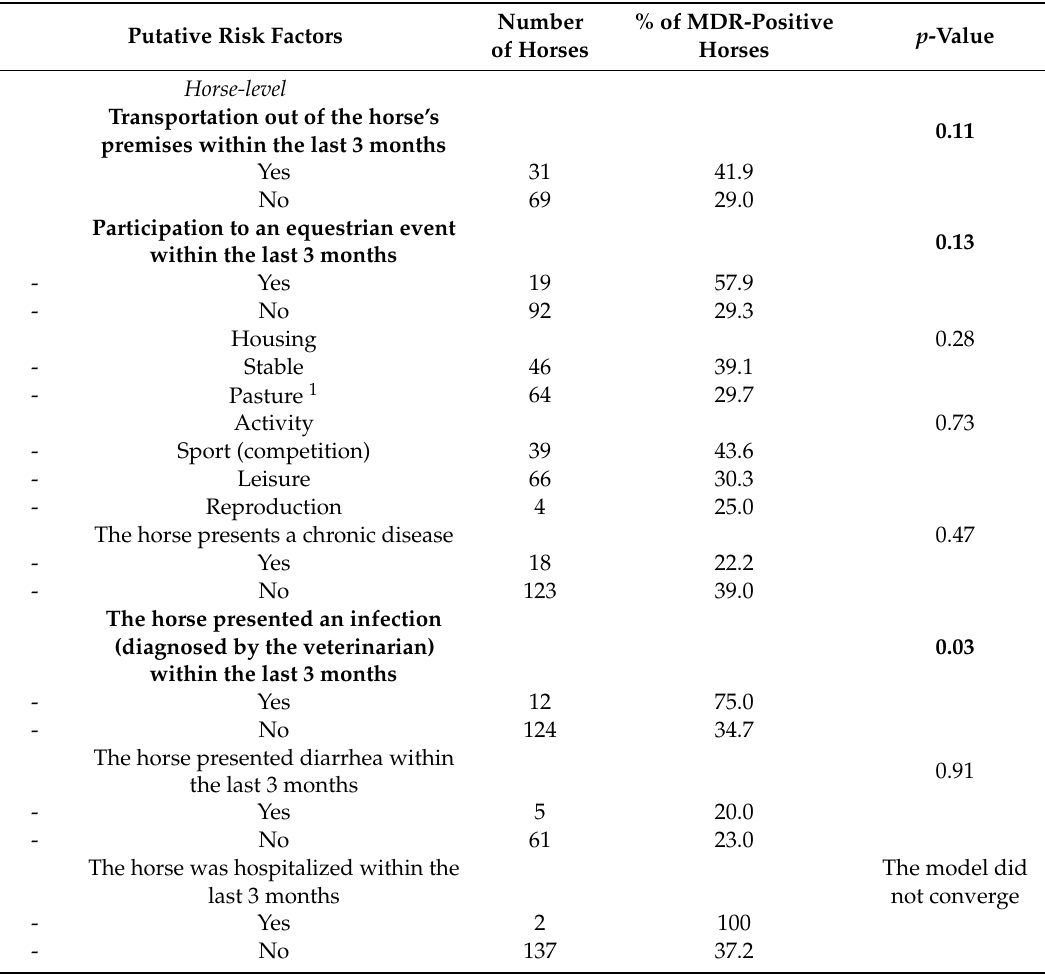
Table 2. Descriptive statistics and p -value (Wald test) from univariable multilevel logistic regression analyses of potential risk factors for MDR status in horses in a cross-sectional study performed on healthy adult horses, in Quebec, in 2015 and 2016. In bold are the factors that were retained for the multivariable